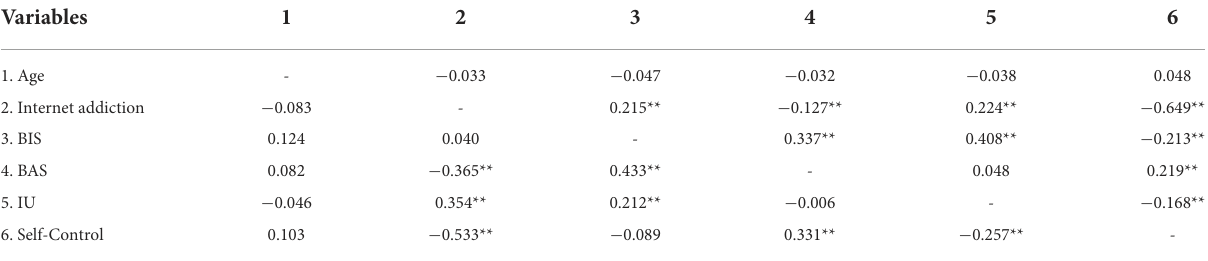
TABLE 2 Associations among the variables for females and males.